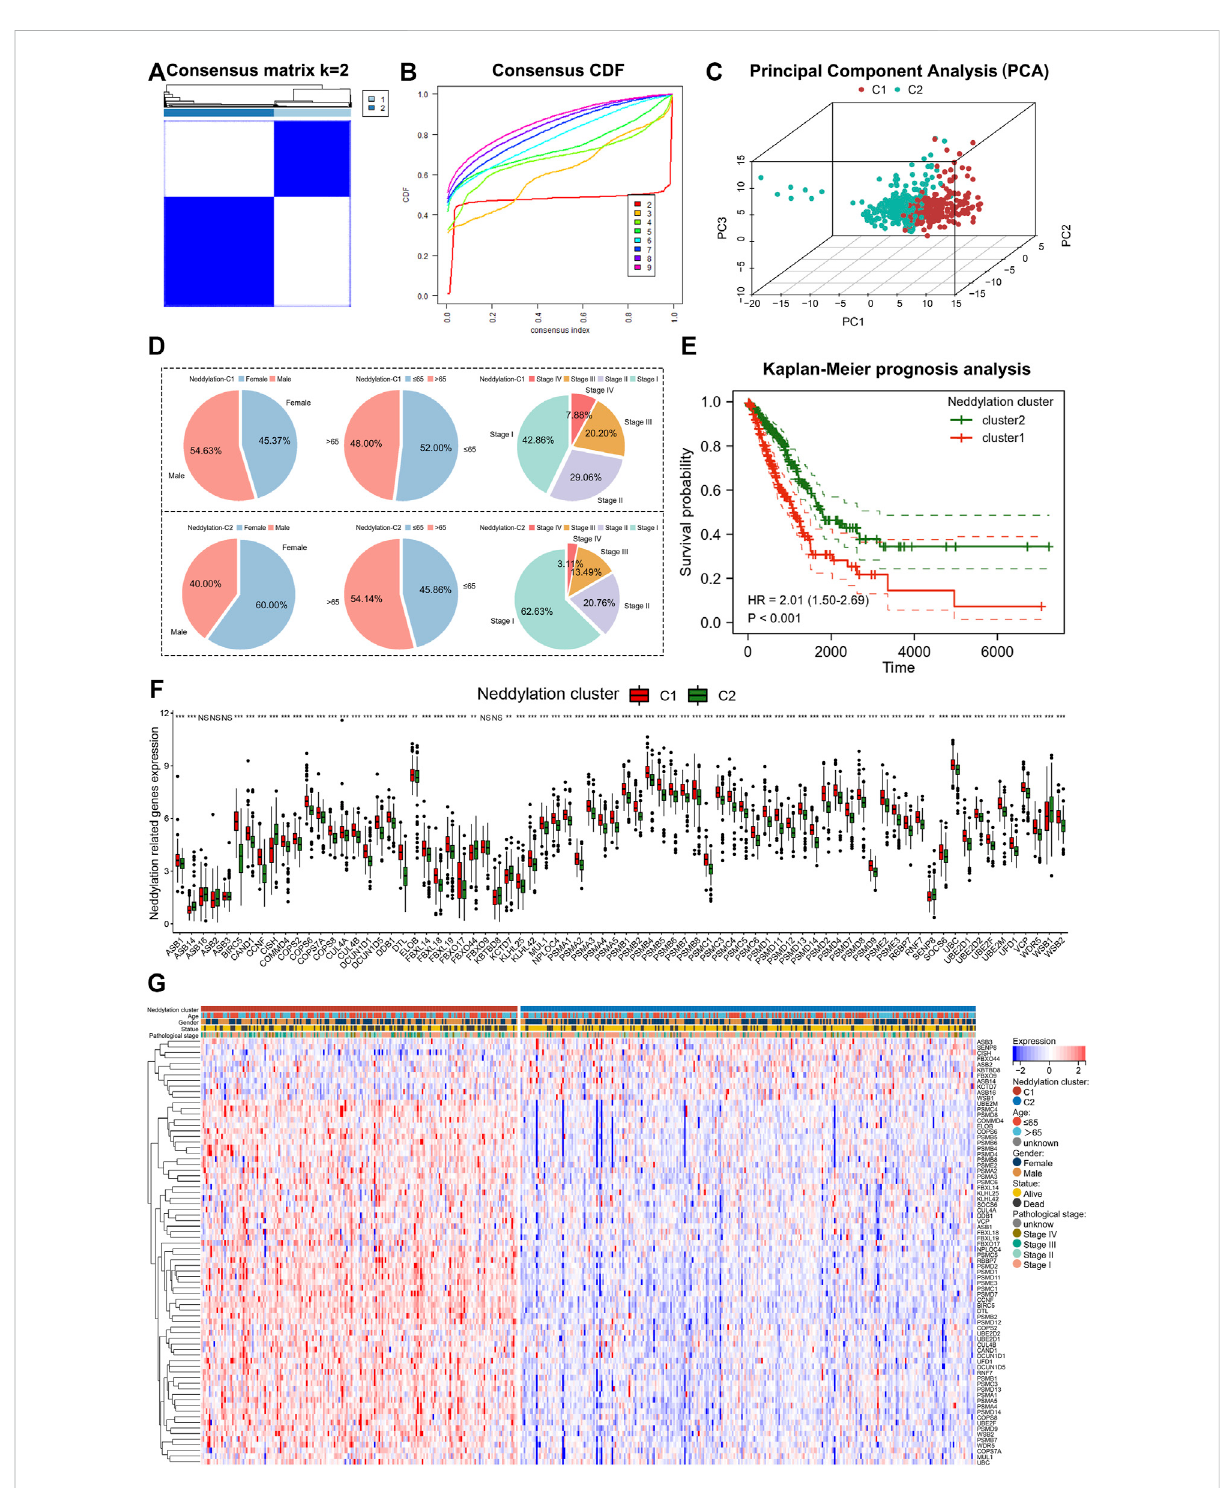
FIGURE 3 Identi fi cation of two patterns associated with neddylation. (A,B) Consensus clustering of 76 genes in LUAD. (C) PCA in two patterns. (D) Differences in clinical factors between the two patterns. (E) Differences in prognosis between the two patterns. (F,G) Expression of 76 prognostic- related genes in two